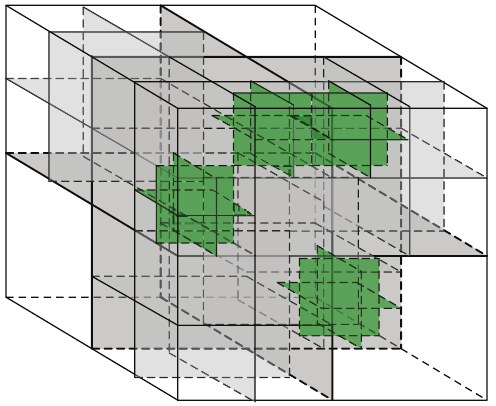
Figure 3: ITS computational domain is decomposed by octree.